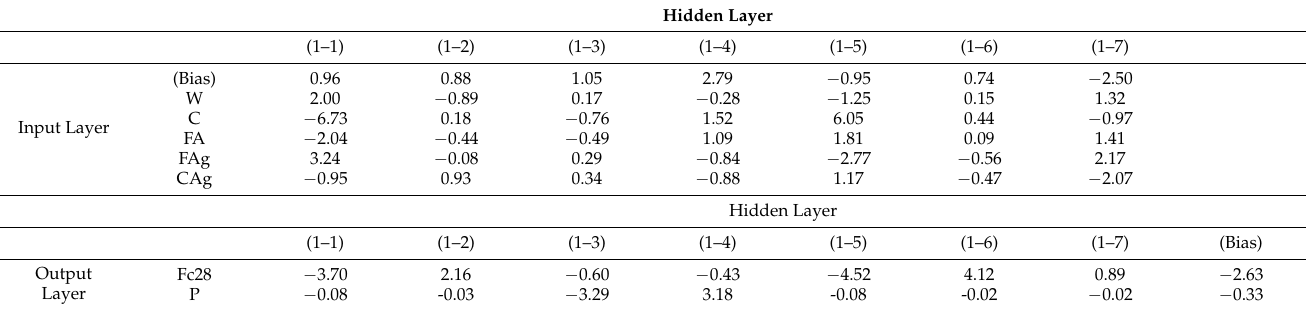
Table 5. Weights matrix for the developed ANN-GRG model.